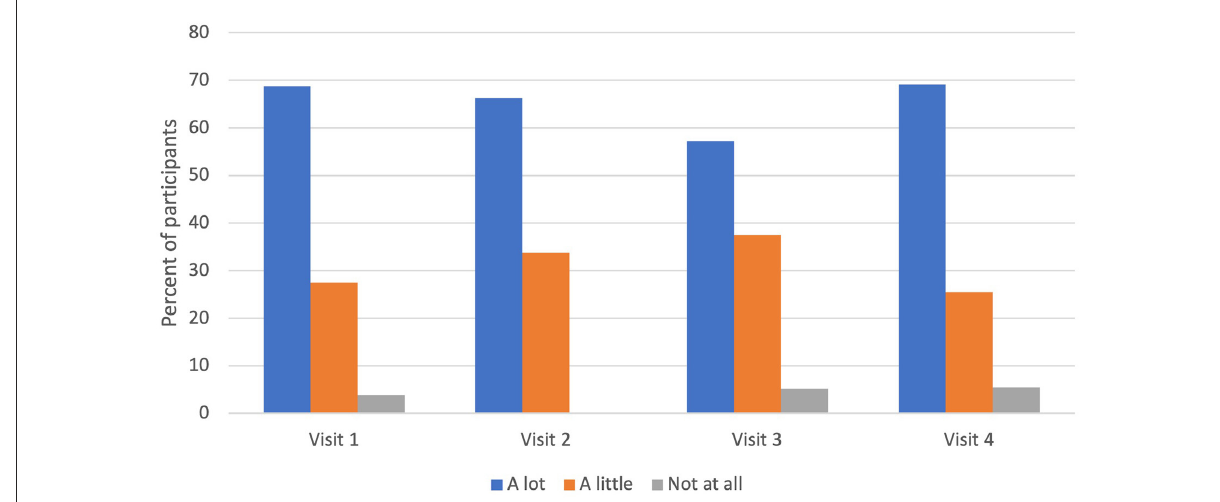
FIGURE2 Child participation during CHW intervention visit. Child participation during a community health worker (CHW) visit remained consistent across time (visits #1-4). Majority of children, if present during a CHW visit, engaged with the CHW a lot.